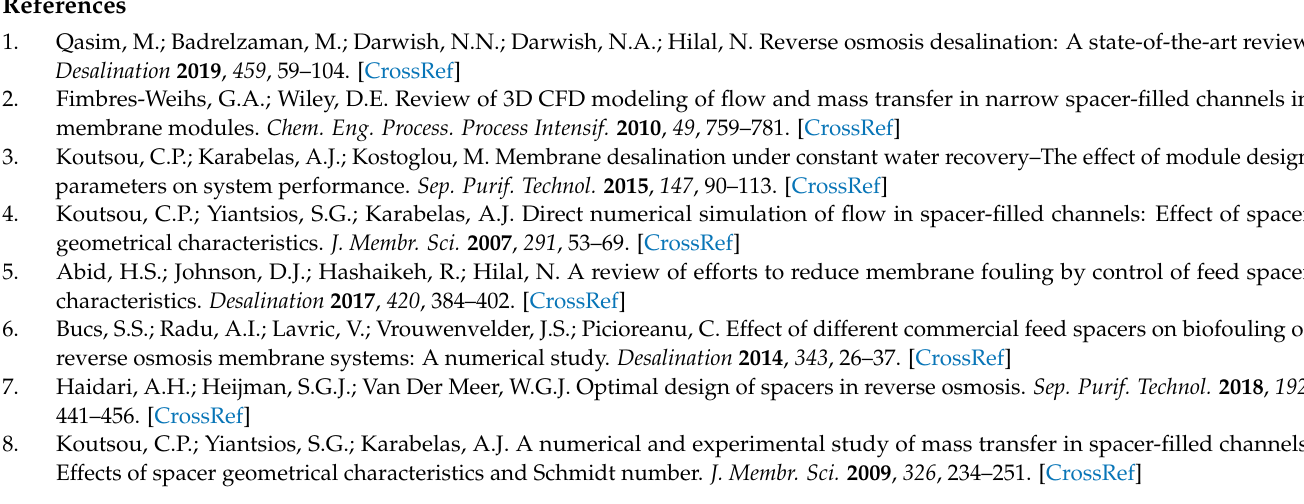
Figure S4: Correlation of dimensionless Sh number parameter as a function of Re number, for gap reduction parameters h/D. Figure S5: Time- and space-average Sh number, on the membrane surface, as a function of ratio D/D (cid:48)